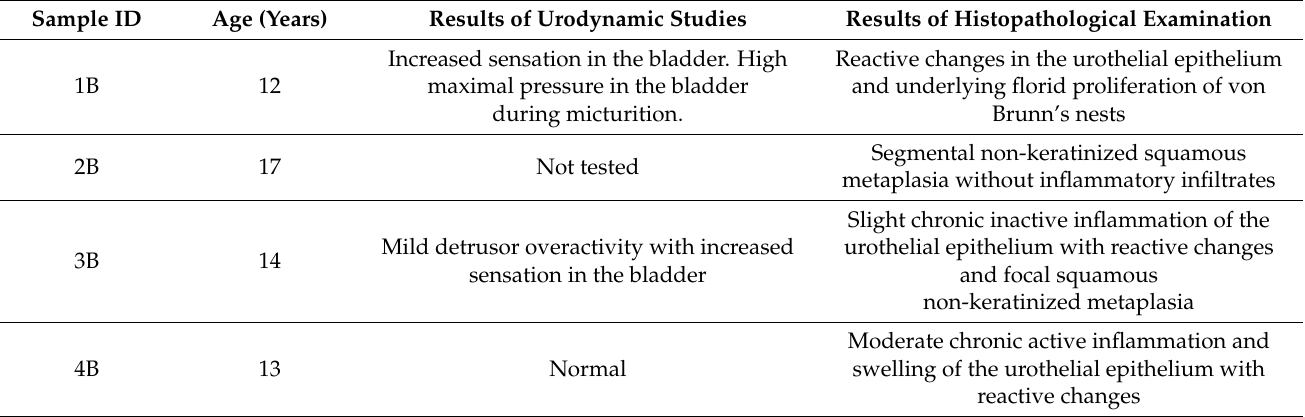
Table 1. Results of urodynamic studies and histopathological findings in biopsy specimens of the trigonal urothelium taken from 17 adolescent girls with urological